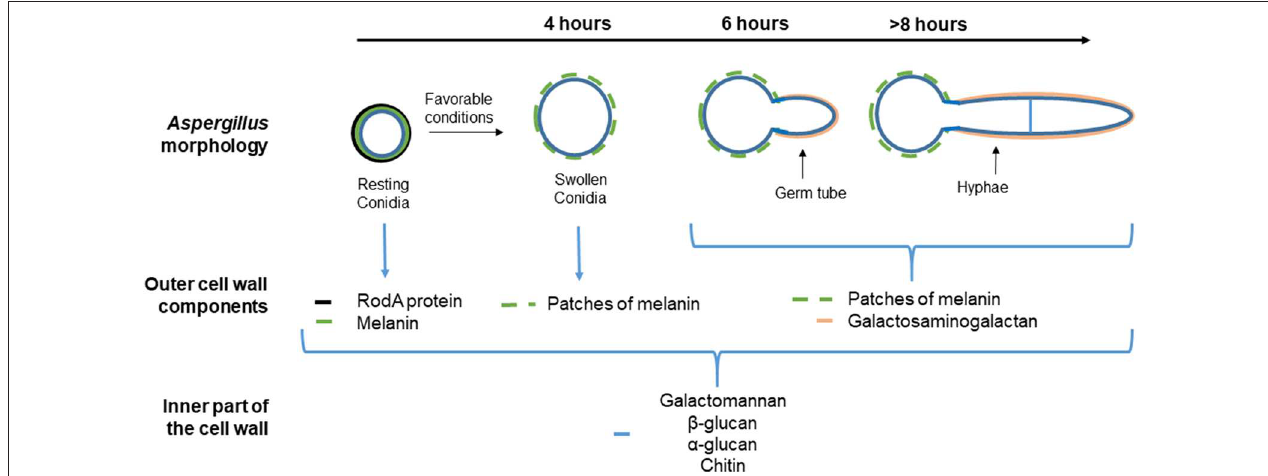
FIGURE 1 | Different morphological stages and compositions of the cell wall during the vegetative cycle of Aspergillus fumigatus . The cell wall of the resting conidia consists of (the most external part to the inner) (i) the rodlet layer (black), composed of the hydrophobin RodA, (ii) the melanin layer below (green), and (iii) polysaccharides (blue). Under favorable conditions, the resting conidia begin to swell after 4h. The rodlet layer is lost by proteolytic degradation and conidium swelling is due to an increase in the internal osmotic pressure. The melanin layer is then disorganized and the inner layer of the swollen conidium forms the mycelium cell wall. After 8h, hyphae are apparent. Then, an extracellular matrix mainly composed of galactosaminogalactan (GAG) (pink) covers up the hyphae. Specific and universal components of each morphotype are shown below each image.